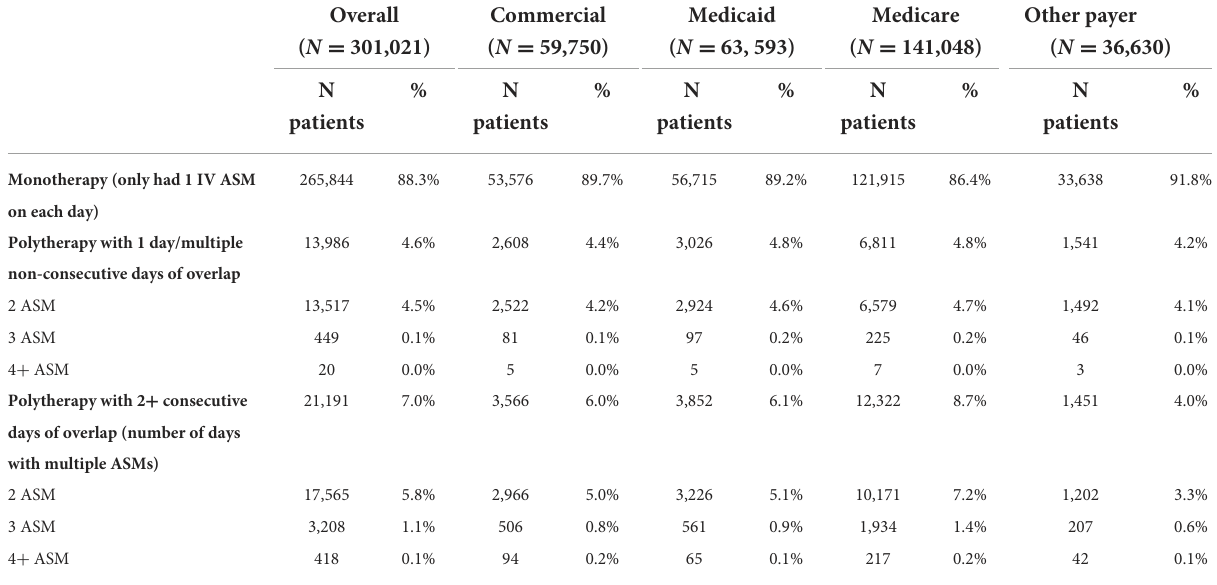
TABLE 2 Concomitant injectable antiseizure medication use among inpatient visits with seizure diagnosis and two or more days of hospital stay by type of primary